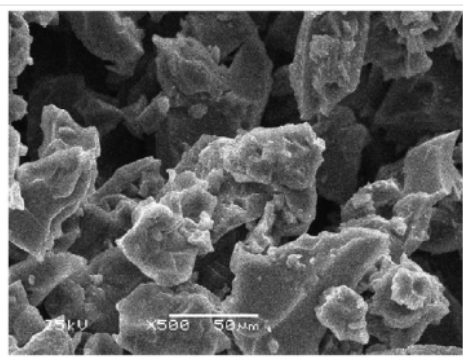
Figure 7. SEM photographs of: ( a ) PMMA, ( b ) SPGMA-co-PMMA; 25:75, ( c ) SPGMA-co-PMMA; 50:50, ( d ) SPGMA-co-PMMA; 75:25 copolymers, and ( e ) S PGMA.